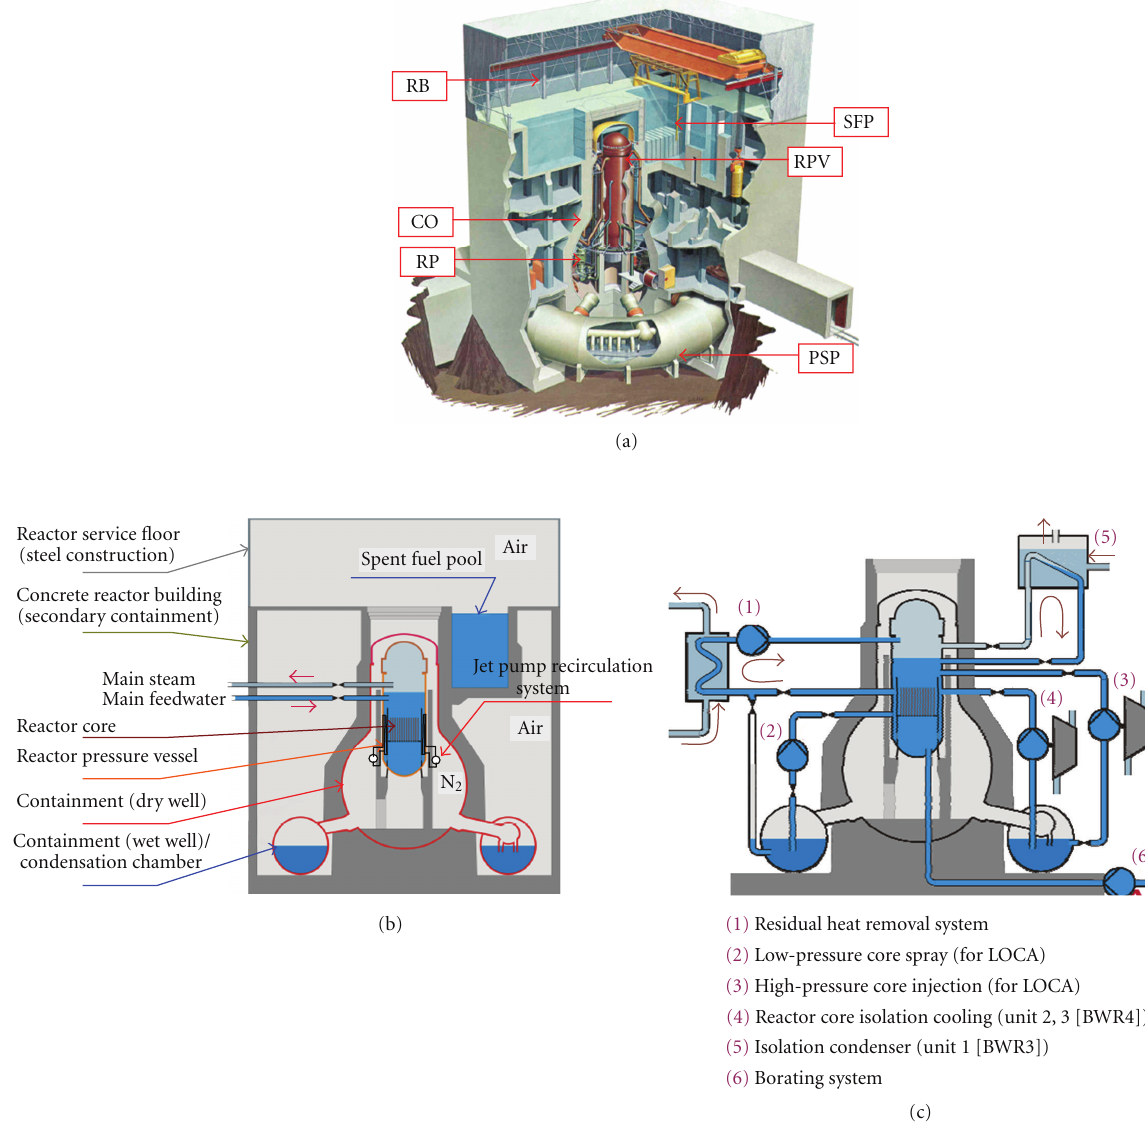
Figure 1: (a) Three-dimensional sketch of the Fukushima Units 1 to 4: Reactor Pressure Vessel (RPV), Containment (CO) with toroidal Pressure Suppression Pool (PSP), and Reactor Building (RB) with Spent Fuel Pool (SFP). (b) Sketch of the Fukushima Units 1 to 4. (c) Sketch of the main ECCS of Fukushima Units 1 to